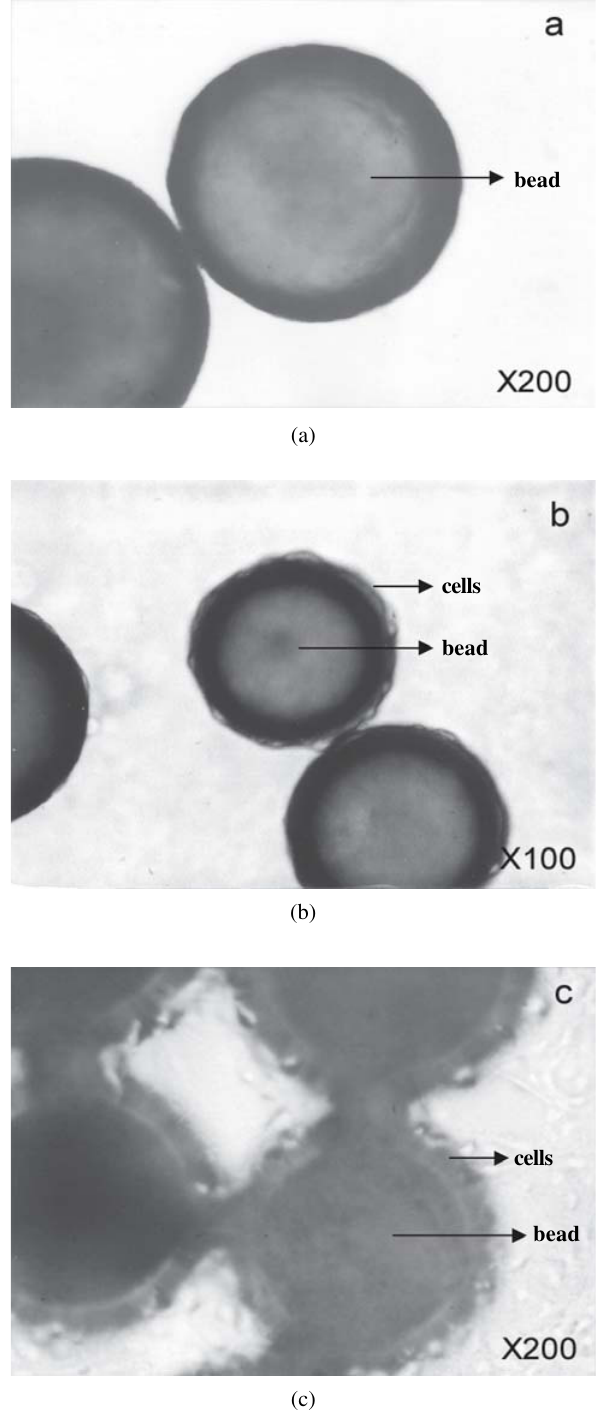
Figure 4. HEMA copolymer beads control (a, 200 ×) and their interaction with the COS-7 cells (b, 100 ×) and (c, 200 ×) seeded in regular medium and incubated at 37 °C for 72 h. Note the cell attachment on the beads in the form of a coating layer and the cell growth in the background